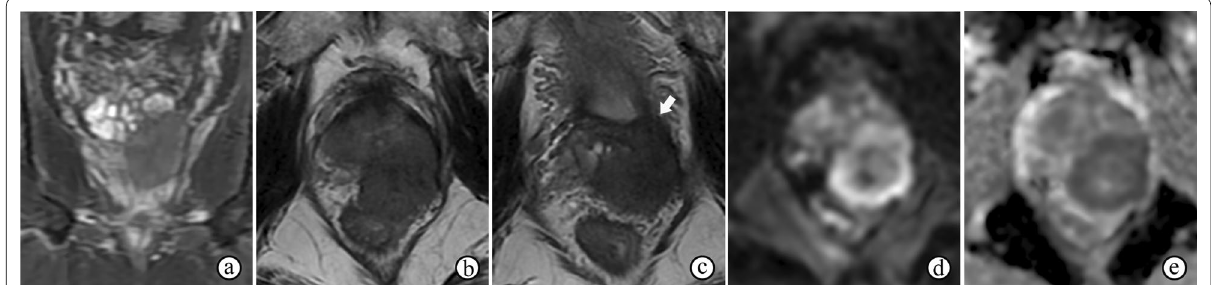
Fig. 9 Local recurrence of urothelial carcinoma of the prostate in a 63-year-old man 1 year after completing chemotherapy. a–c Coronal fat-suppressed T2- ( a ) and axial T2WI ( b, c ) show an inhomogeneously isointense mass primarily located in the left lobe of the prostate and left seminal vesicle, invading a corner of the bladder (arrow on c ). d, e DWI at a b-value of 1400 s/mm 2 and ADC maps show restricted diffusion in the periphery of the mass